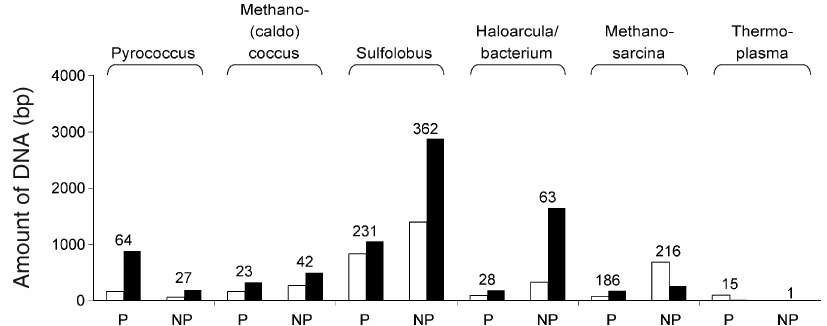
Figure 4. Cumulative size of insertion (open bars) and deletion (filled bars) events in positional (P) and non-positional (NP) pseudogenes of archaeal genomes. Numbers above the bars indicate numbers of pseudogenes on which the analyses are